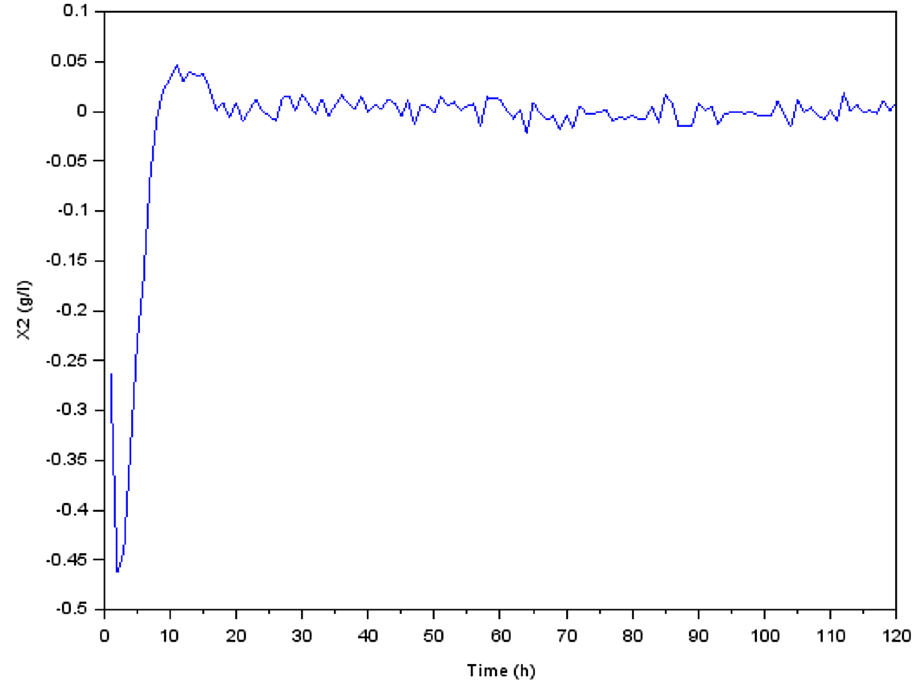
Figure 6. Variation of acetoclastic methanogenic bacteria concentration X 2 (g/l).